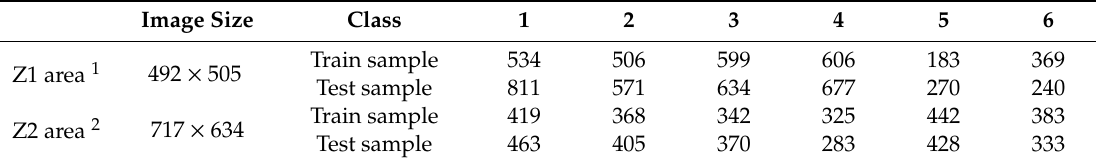
Figure 6. Locations of study areas 1 and 2 and acoustic backscatter images. ( a ) Sediment image of the Z1 area, and label distribution of the training samples from Dataset 1. ( b ) Sediment image of the Z2 area, and label distribution of training samples from Dataset 2. Table 2. Sample selection statistics of acoustic backscatter images.